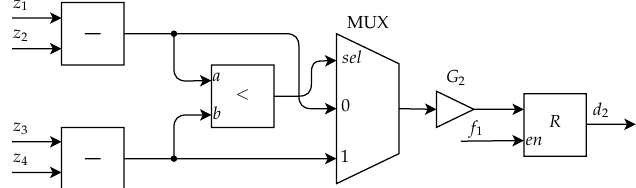
Figure 15. Architecture of the Diameter Calculation Submodule to determine the diameter.